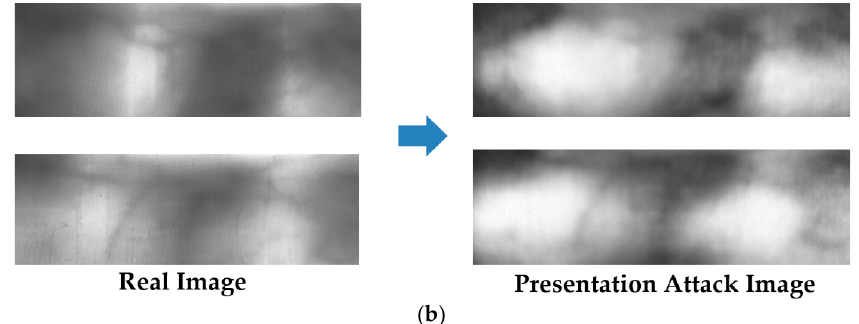
Figure 5. Example of real and presentation attack finger-vein images in Idiap database: ( a ) real and